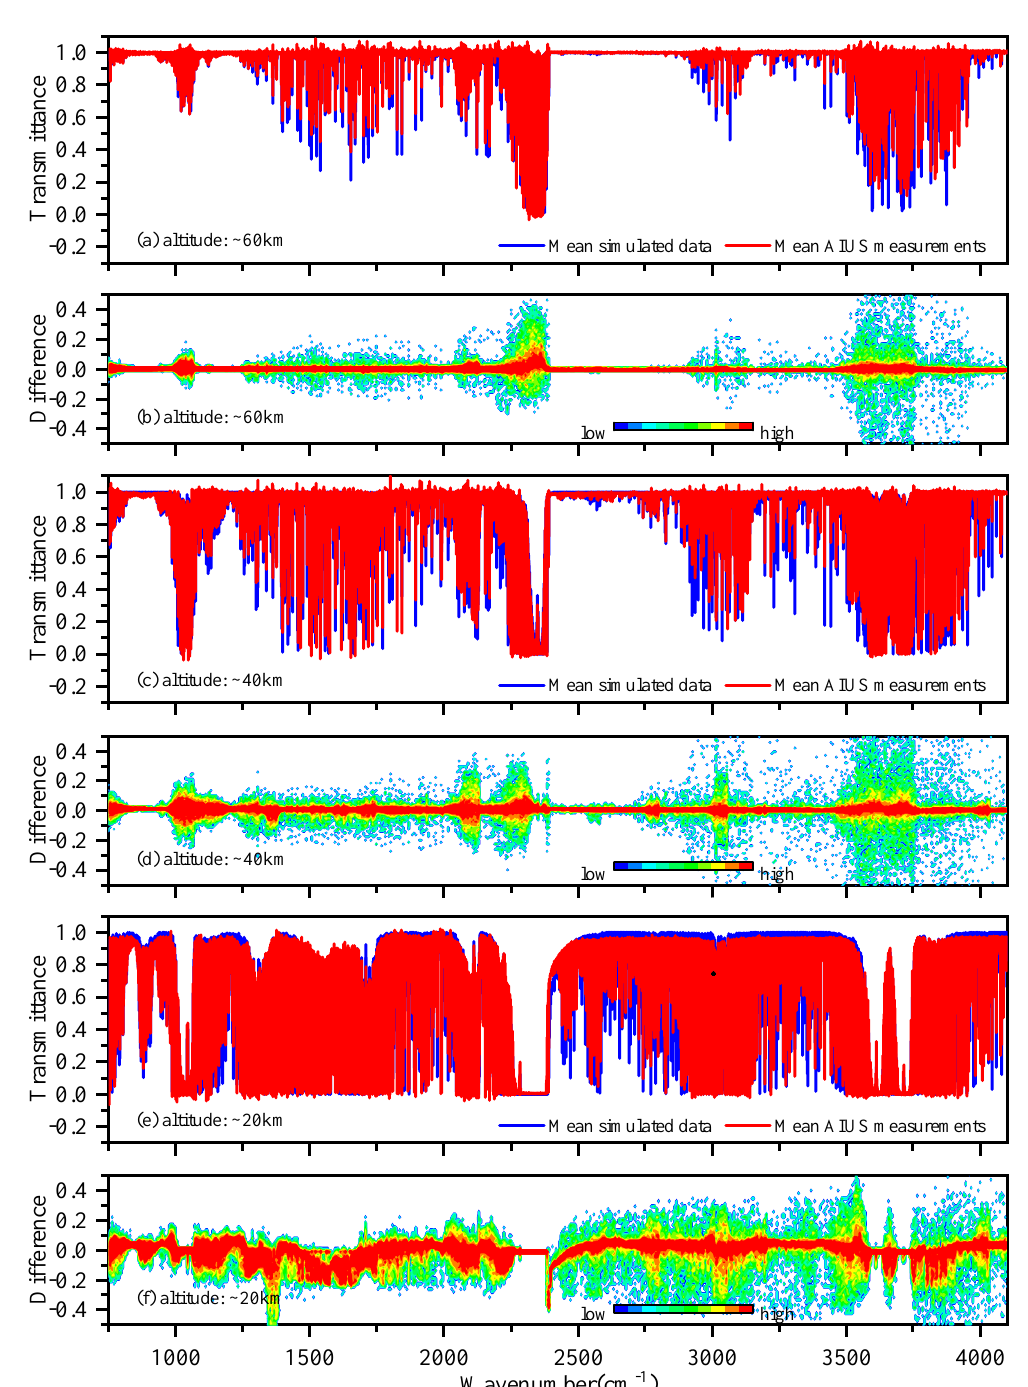
Figure 2. The comparison between mean AIUS measurements and the mean simulated data. Figure 3 shows the frequency distribution histograms of the differences between AIUS measurements and simulations at three altitudes (60 km, 40 km, and 20 km) in five spectral bands. Figure 3a1–a3 shows the histograms for the full spectral band (750–4100 cm − 1 ) of AIUS. There were 73% of the transmittance differences within ± 0.05 at 20 km, 92% at 40 km, and 96% at 60 km. Figure 3b1–b3,c1–c3 are the histograms for the MCT and InSb bands. The histograms of the two bands were almost the same, which indicated that their detection ability was comparable. Figure 3d1–d3,e1–e3 are the histograms of two spectral bands (2000–2350 cm − 1 and 3500–4000 cm − 1 , respectively) with large transmittance